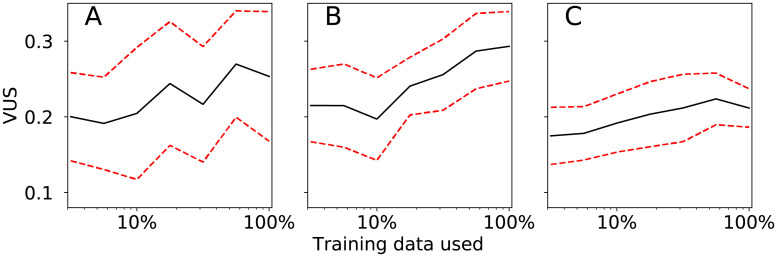
Learning curves.These plots display the volume under the receiver operating characteristic surface for the HMM classifier as the percentage of training data used to train the model varies. The full training set contained a randomly selected subset of up to 85% of the 4456 data points with known pain scores and the testing data contained the remaining 15%. The black (solid) curves correspond to the mean VUS averaged over 20 train-test splits. The red (dashed) curves correspond to the mean VUS ± one standard deviation to provide a measure of the variability in the performance. Panel A corresponds to the direct classification problem; panel B corresponds to the median-referenced classification problem; and panel C corresponds to the difference classification problem. The spacing on the horizontal axis is logarithmic.